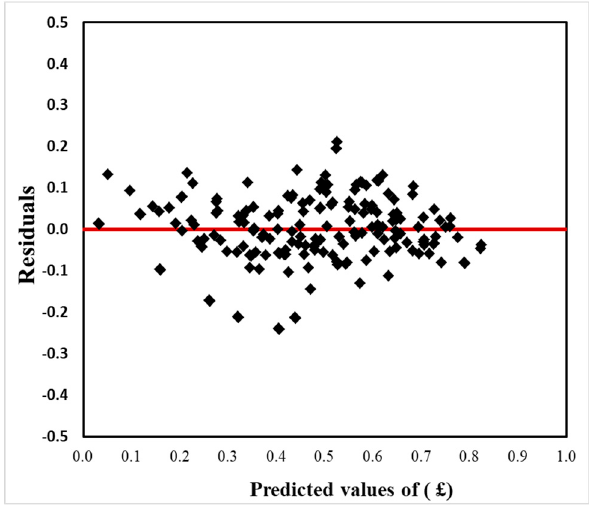
Figure 32. Residuals versus Predicted £ from Equation (2).